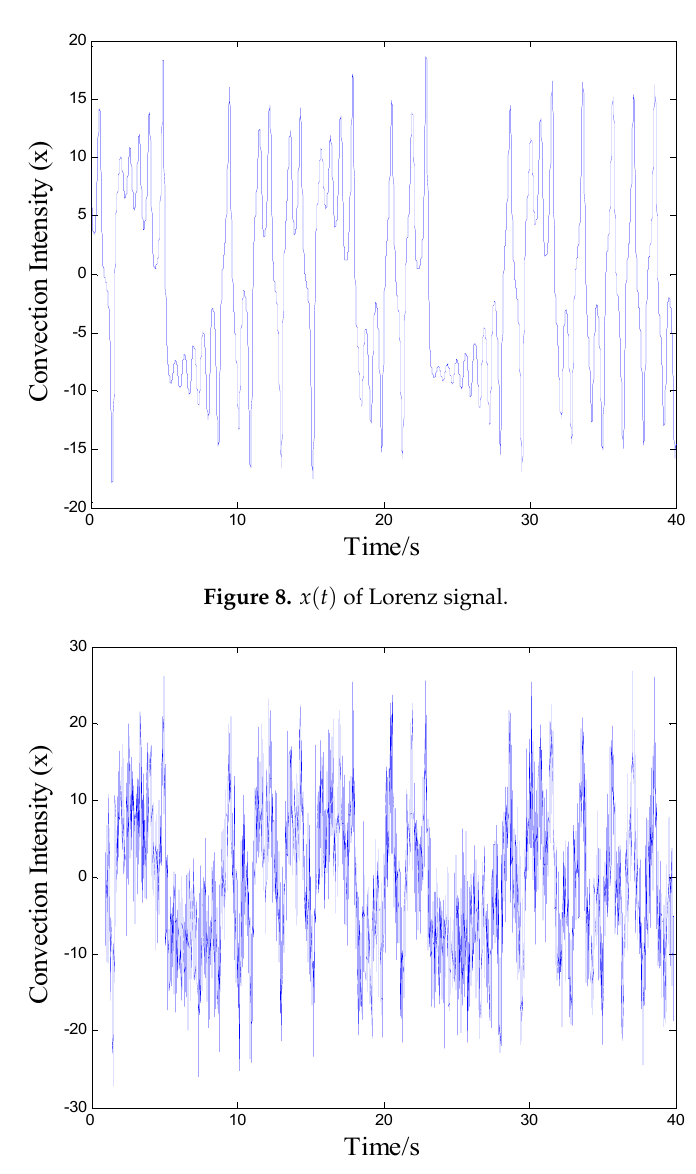
Figure 9. 𝑥(𝑡) of Lorenz signal with noises